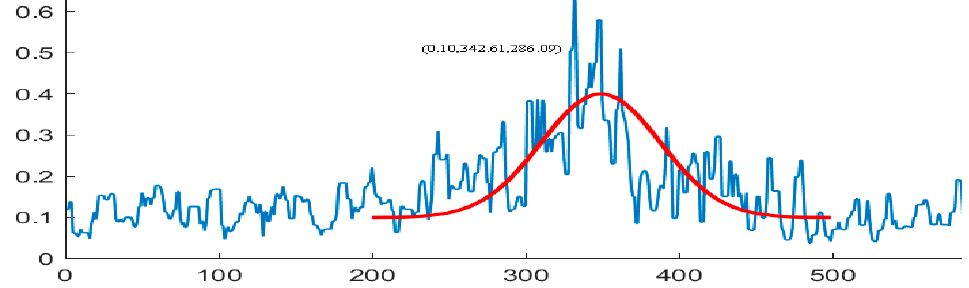
Figure 15. Example sand wave profile waveform matching.